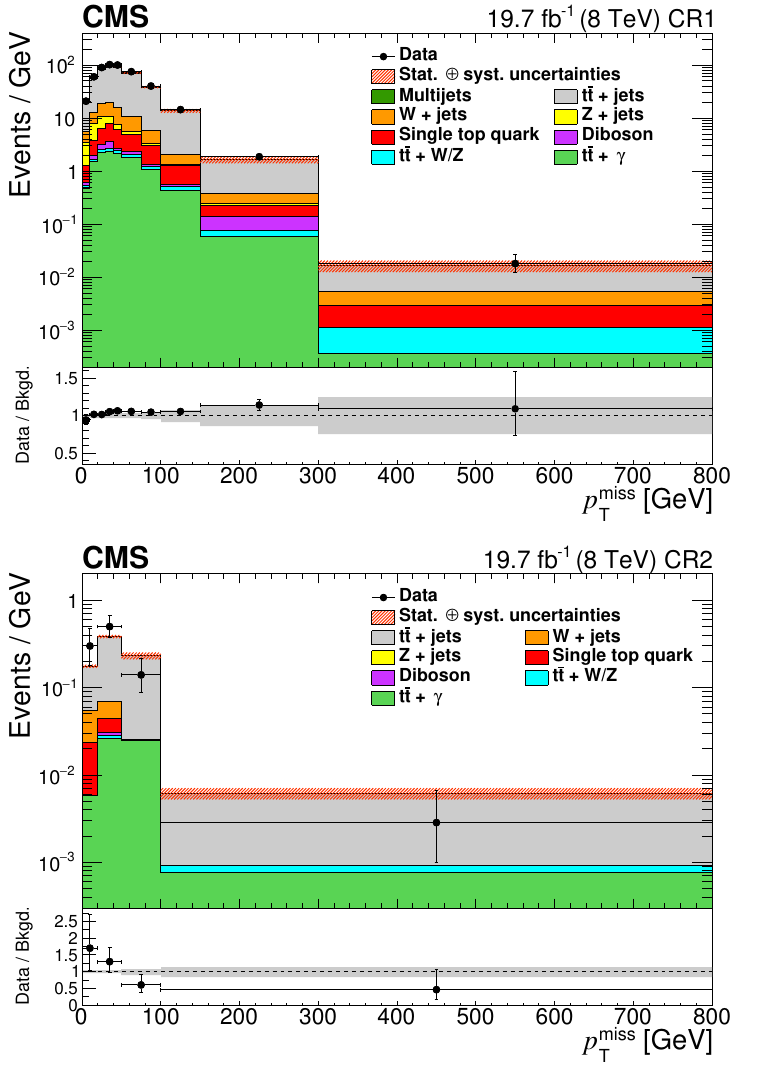
Figure 3 . Comparison of data and simulated events as a function of p miss (cid:22) control regions is shown: (upper pane) CR1 with one fake photon, and (lower pane) CR2 with two fake photons. The content of each bin is normalized to its bin width. The ratios of data to background are shown below the two panels. The overall uncertainties are obtained from the sum in quadrature of the statistical and systematic components. Note the Diboson background includes WW, WZ, ZZ, W+gamma, and Z+gamma.